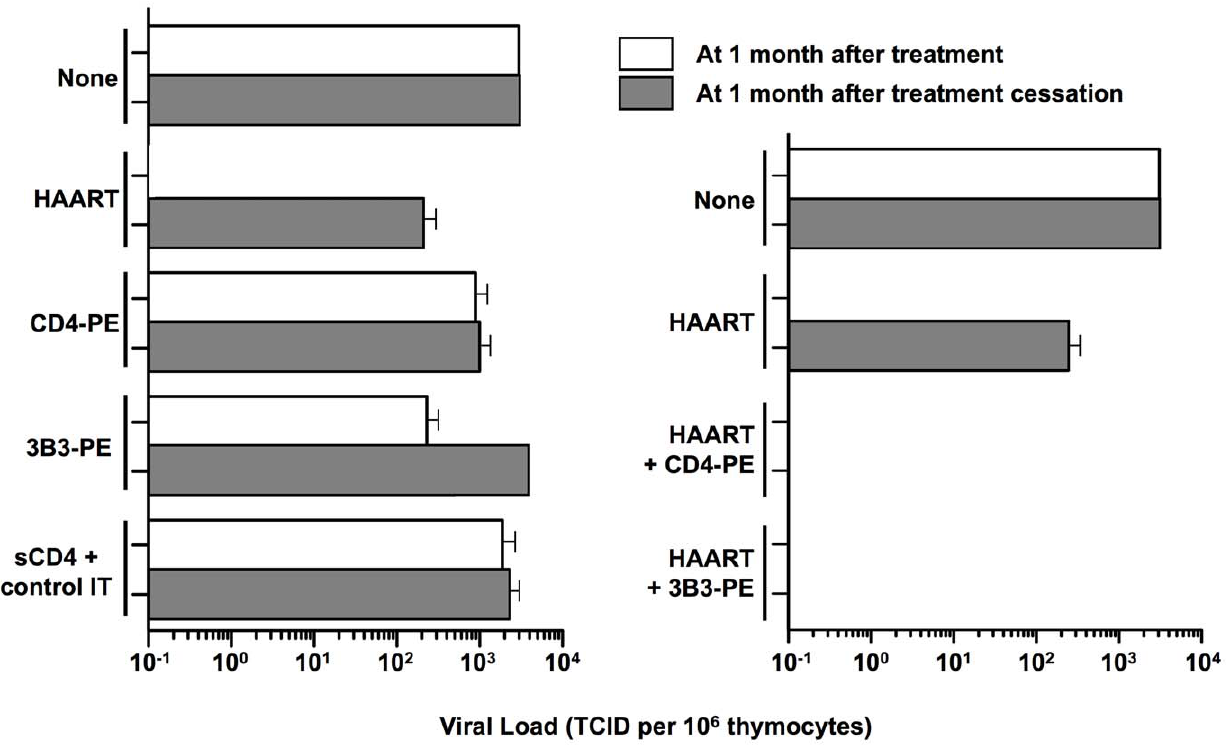
Figure 2. Effects of complementing HAART with Env-targeted toxins in thy/liv SCID-hu mouse model. Thy/liv-SCID-hu mice were injected intraperitoneally with HIV and either left untreated (None) or immediately started on the indicated treatment. One month later, the left thy/ liv implants were biopsied, and viral loads were analyzed by quantitative coculture ( open bars ). Drug therapy was then stopped, and after 1 month the left thy/liv implant of each mouse was rebiopsied and the viral load quantitated ( filled bars ). The data are presented as the TCID/10 6 thymocytes; the mean values ( 6 SEM) were calculated for each group. Left panel, HAART (zidovudine + lamivudine + ritonavir) or immunotoxins alone; right panel, HAART alone compared to HAART plus immunotoxins. Data adapted from [45] ( (cid:2) 2000 by Goldstein et